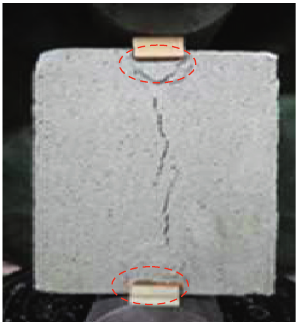
Figure 8: Splitting failure diagram of cast-in-situ foamed concrete.